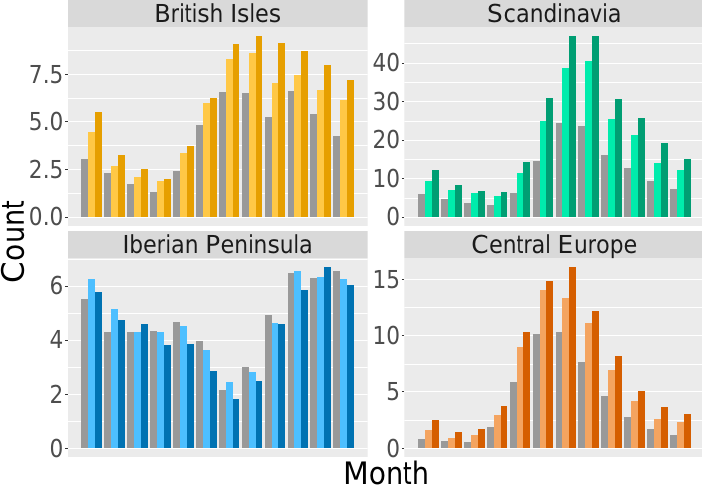
Figure 7. Seasonal cycle of detected daily and multi-day heavy precipitation events in four different European regions (British Isles, Iberian Peninsula, Scandinavia and Central Europe). The ensemble mean for the historical simulation (grey), the RCP4.5 (light colour) and the RCP8.5 (bright colour) scenario simulation for the period 2071–2100 are shown.